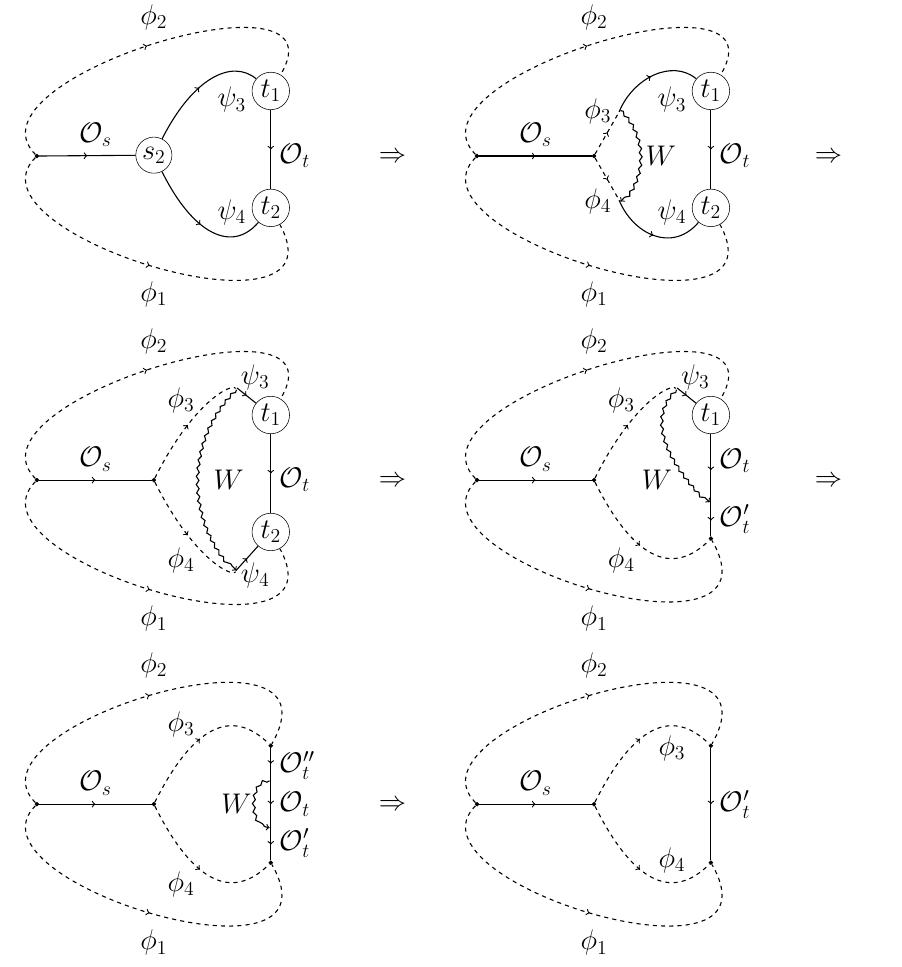
Figure 1 . Step by step diagrammatic illustration for the decomposition of the fermionic 6 j symbol relevant for h